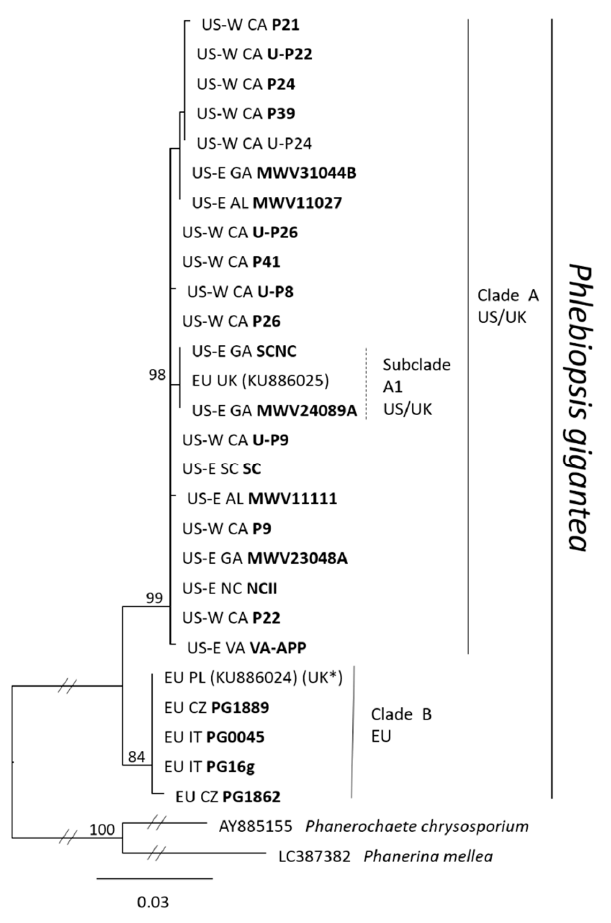
Figure 7. Maximum likelihood phylogram obtained from the TEF1- α sequence alignment of Phlebiopsis gigantea . Phanerochaete chrysosporium and Phanerina mellea were used as outgroup taxa. ML bootstrap percentages ≥ 70% are given above each clade. Labels indicate: geographic area, state, isolate code (in bold for sequences newly generated) and GenBank code brackets for sequences retrieved from